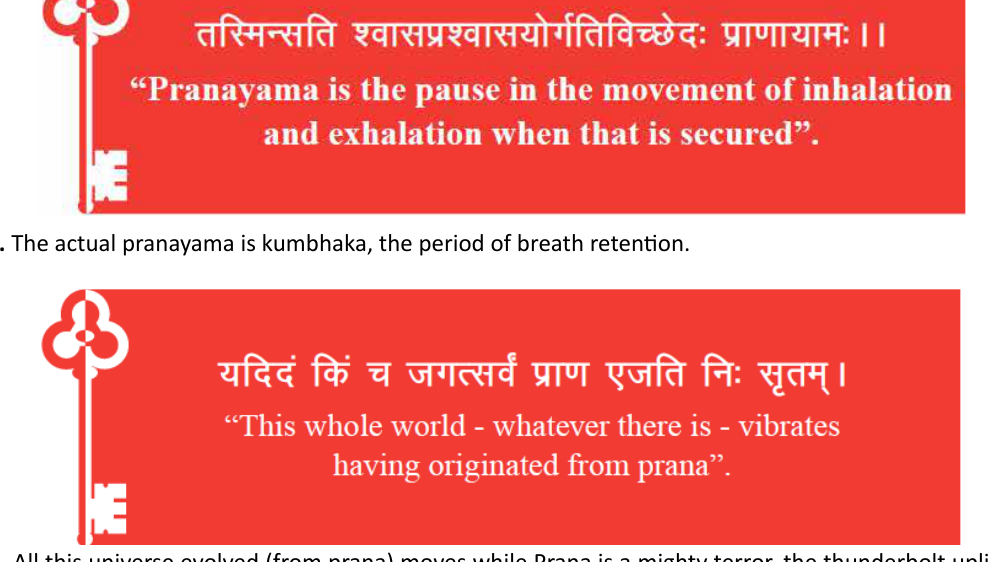
Figure 2. All this universe evolved (from prana) moves while Prana is a mighty terror, the thunderbolt uplifted; those who know this become